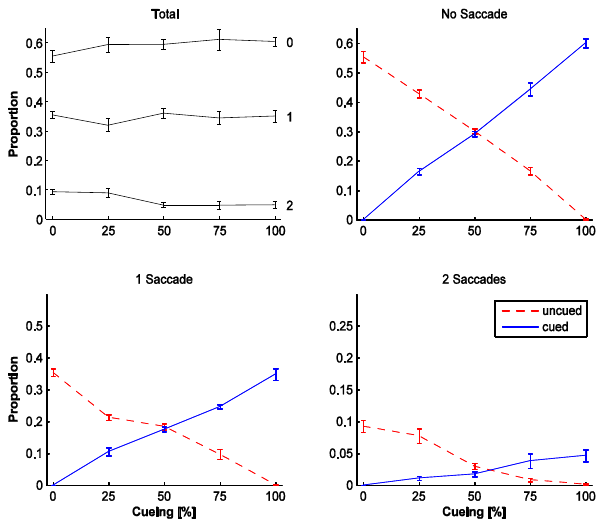
Figure 3. Proportion of saccades - made toward targets (markers or letters) before letter-identification selection was carried out - as a function of cueing conditions (0%, 25%, …, 100%). Upper left: Total proportion (letters and cues) for 0 (attentional shift only for identification), 1 and 2 saccades. Upper right: Proportion of identification selections for uncued (dashed) and cued (solid) letters, for which no saccade toward the target was made. Lower left: Selection proportion for one saccade. Lower right: Selection proportion for two saccades. Error bars = standard error of inter-observer performance.